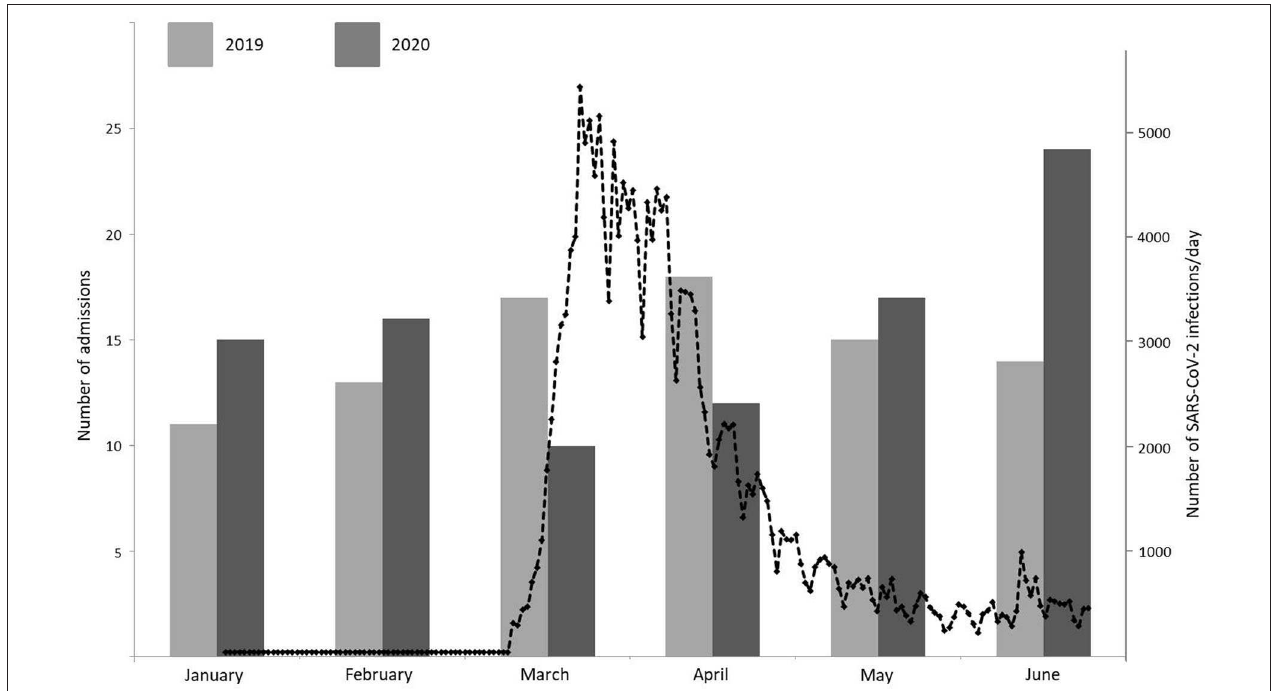
FIGURE 2 | Monthly admission rates for traumatic intracranial hemorrhage between January and June 2019 (light gray) and January and June 2020 (dark gray) and daily new infections in Germany with SARS-CoV-2 from March 2nd to June 30th (black dotted